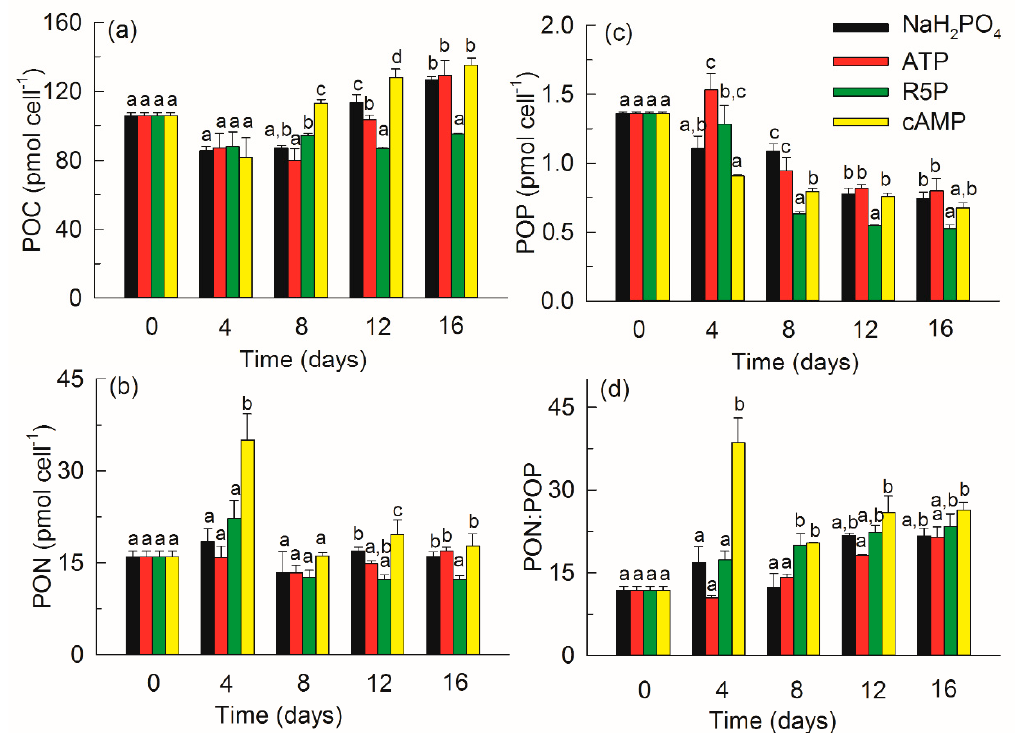
Figure 5. Particulate organic carbon (POC) ( a ), particulate organic nitrogen (PON) ( b ), particulate organic phosphorus (POP) ( c ), and PON:POP ratio ( d ) of Karenia mikimotoi in the NaH 2 PO 4 , adenosine triphosphate (ATP), ribulose 5-phosphate (R5P), and cyclic adenosine monophosphate (cAMP) treatments on days 0, 4, 8, 12, and 16. The values are the mean ± S.D. ( n = 3). Significant differences ( p < 0.05) among different phosphorus substrates are shown with different lowercase letters.